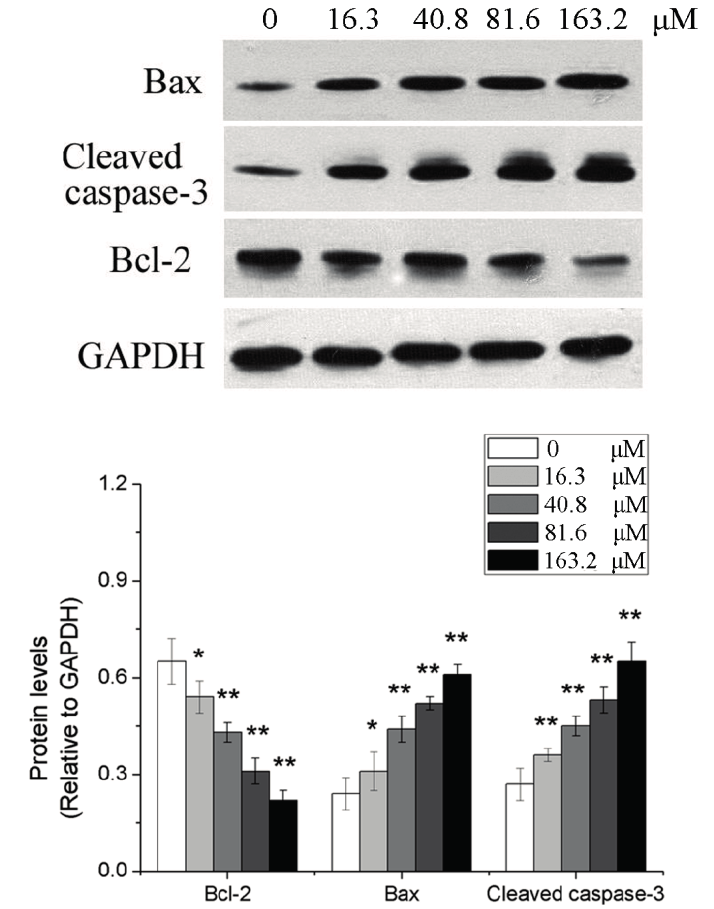
Figure 5. The effect of PD on the expressions of Bcl-2, Bax and cleaved caspase-3 in U251 cells. U251 cells were treated with 0, 16.3, 40.8, 81.6 and 163.2 μ M of PD for 48 h. Then the expressions of target protein were evaluated by western blot assay. Each value is presented as mean ± SD ( n = 3). * p < 0.05 compared with 0 μ M PD; ** p < 0.01 compared with 0 μ M